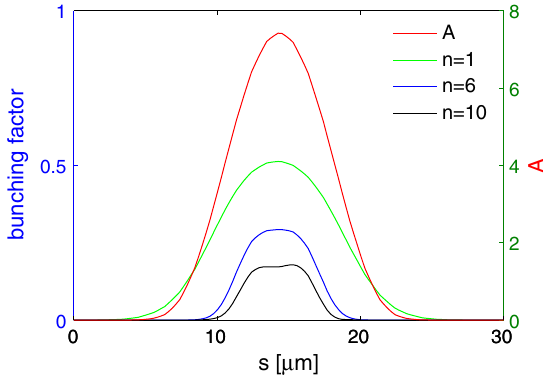
FIG. 10. Normalized TBPs of the electron bunching as a function of the modulator period number for different harmonics of the seed ( n ¼ 10 , 20, and 30).